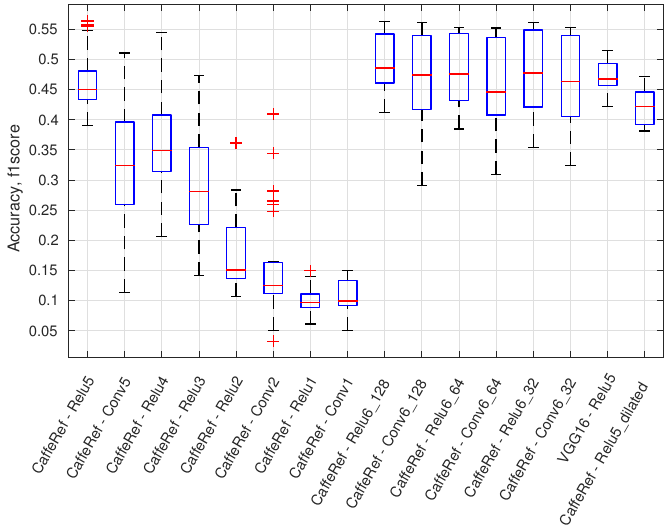
Figure 12. Accuracy (f1 score) for a given output layer across all model normality types and image model